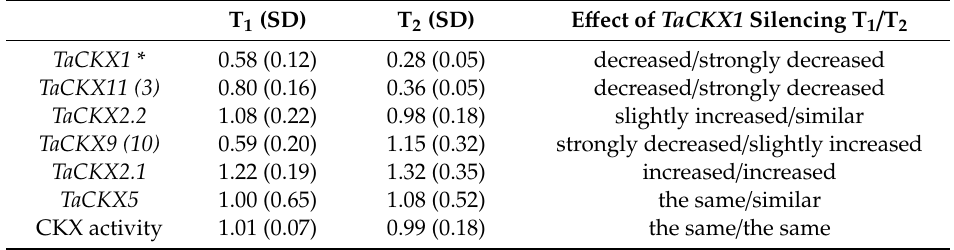
Table 1. E ff ect of TaCKX1 silencing on expression levels of selected TaCKX genes presented by expression ratio indicator (mean value in silent / mean value in non-silent, control plants) in T 1 and T 2